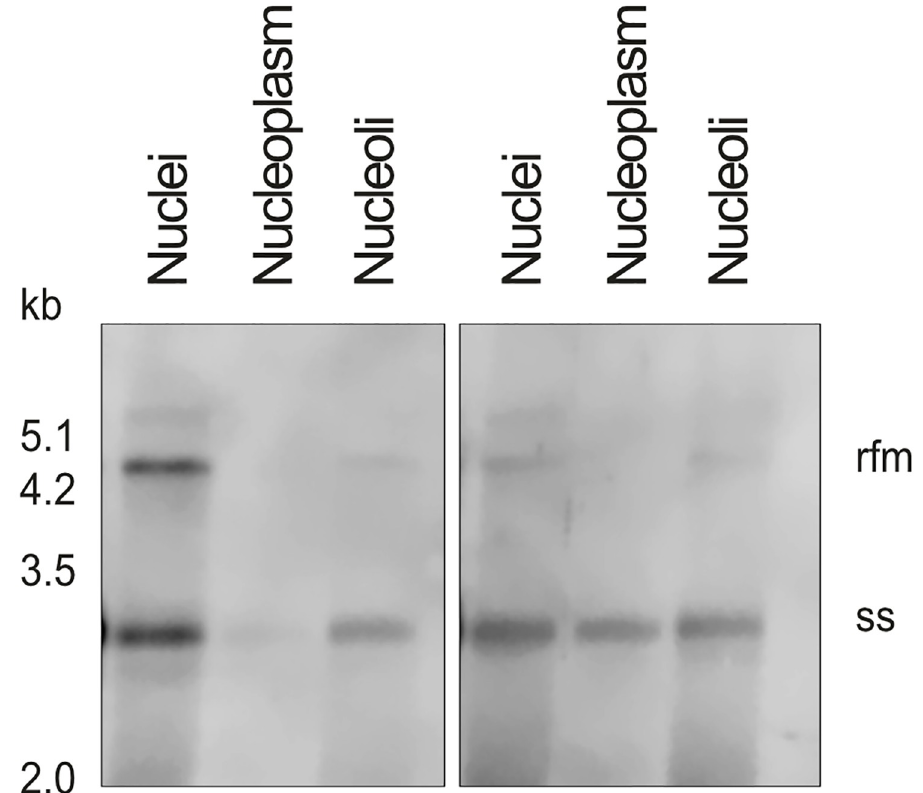
Fig 5. Southern analysis of AAV2 DNA in cell fractions. Southern Blot of denatured Hirt DNA extracted at 24 and 48 hpi from isolated nuclei, nucleoplasm, or nucleoli of NHF cells infected with wtAAV2 (MOI 20’000; 1.5x10 6 cell equivalents per lane). AAV2 DNA was visualized with an AAV2 rep -specific probe disclosing bands representing the single-stranded (ss)AAV2 DNA and the replication form monomer (rfm; product of AAV2 second-strand synthesis). Representative images from two independent experiments are